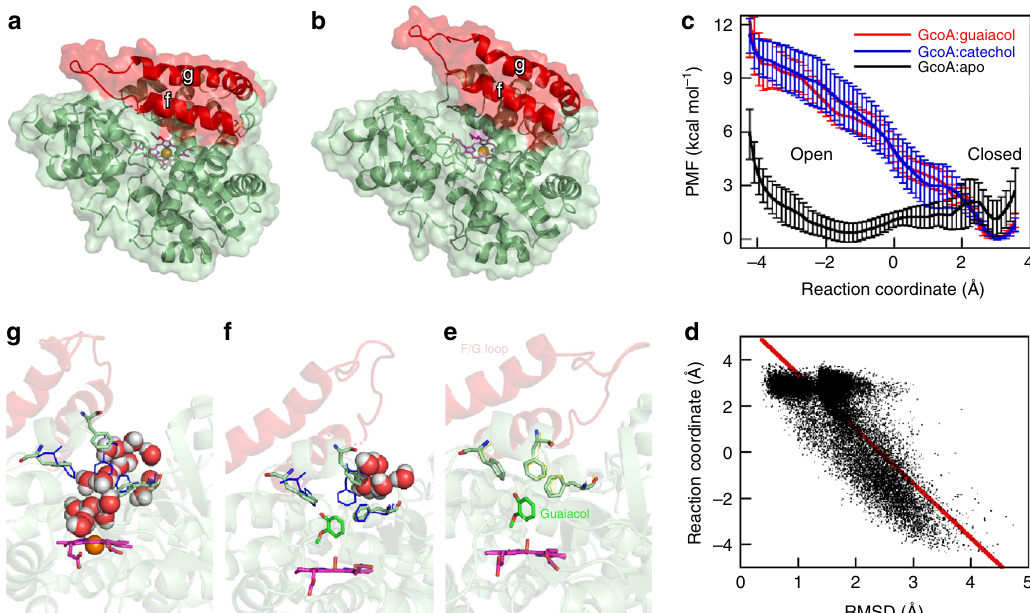
Fig. 5 MD simulations of GcoA demonstrate opening and closing of the active site correlated with Phe side chain motions and substrate binding. a Closed and b open GcoA structures obtained from MD simulations highlighting in red the open-close motion of the helices F and G. c Free energy pro fi les (calculated as the potential of mean force — PMF) of the open-close motions of GcoA:apo, GcoA:guaiacol, and GcoA:catechol. PMFs were calculated using 10-ns blocks from the umbrella sampling simulations and the block averages were plotted with the corresponding standard deviations represented as error bars. d Scatter plot of the reaction coordinate (a metric of the open-close motions) and RMSD of Phe75, Phe169, and Phe395 relative to the crystal structure (a metric of the breathing motions of these residues) obtained from simulations of GcoA:apo, showing the correlation between the degree of opening of GcoA and the con fi guration of the binding pocket. Con fi guration of residues Phe75, Phe169, and Phe395 (in cyan) e in the most closed GcoA structure, f in a partially open GcoA structure, and g in a fully open structure, showing that the aromatics (from left to right; Phe75, Phe169, Phe395) prevent water (shown as space fi lling representation) from penetrating the binding pocket in f but not in g , where the expansion of the Phe residues allows the penetration of water into the binding pocket. For visual clarity, the water molecules represented in g and f correspond to those located within 7 Å of the Phe side chains and within 16 Å of the heme Fe atom. The con fi guration of the Phe residues in the crystal structure is shown as thin blue